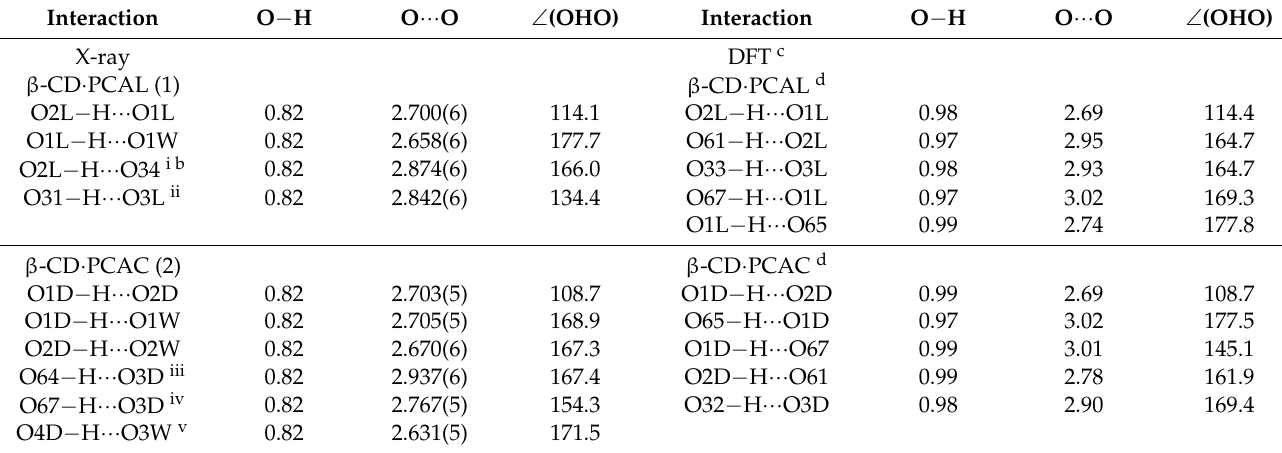
Table 2. O − H ··· O Hydrogen Bonds Involving PCAL and PCAC from X-ray Analysis and DFT Calculation [Å, o ]. a.